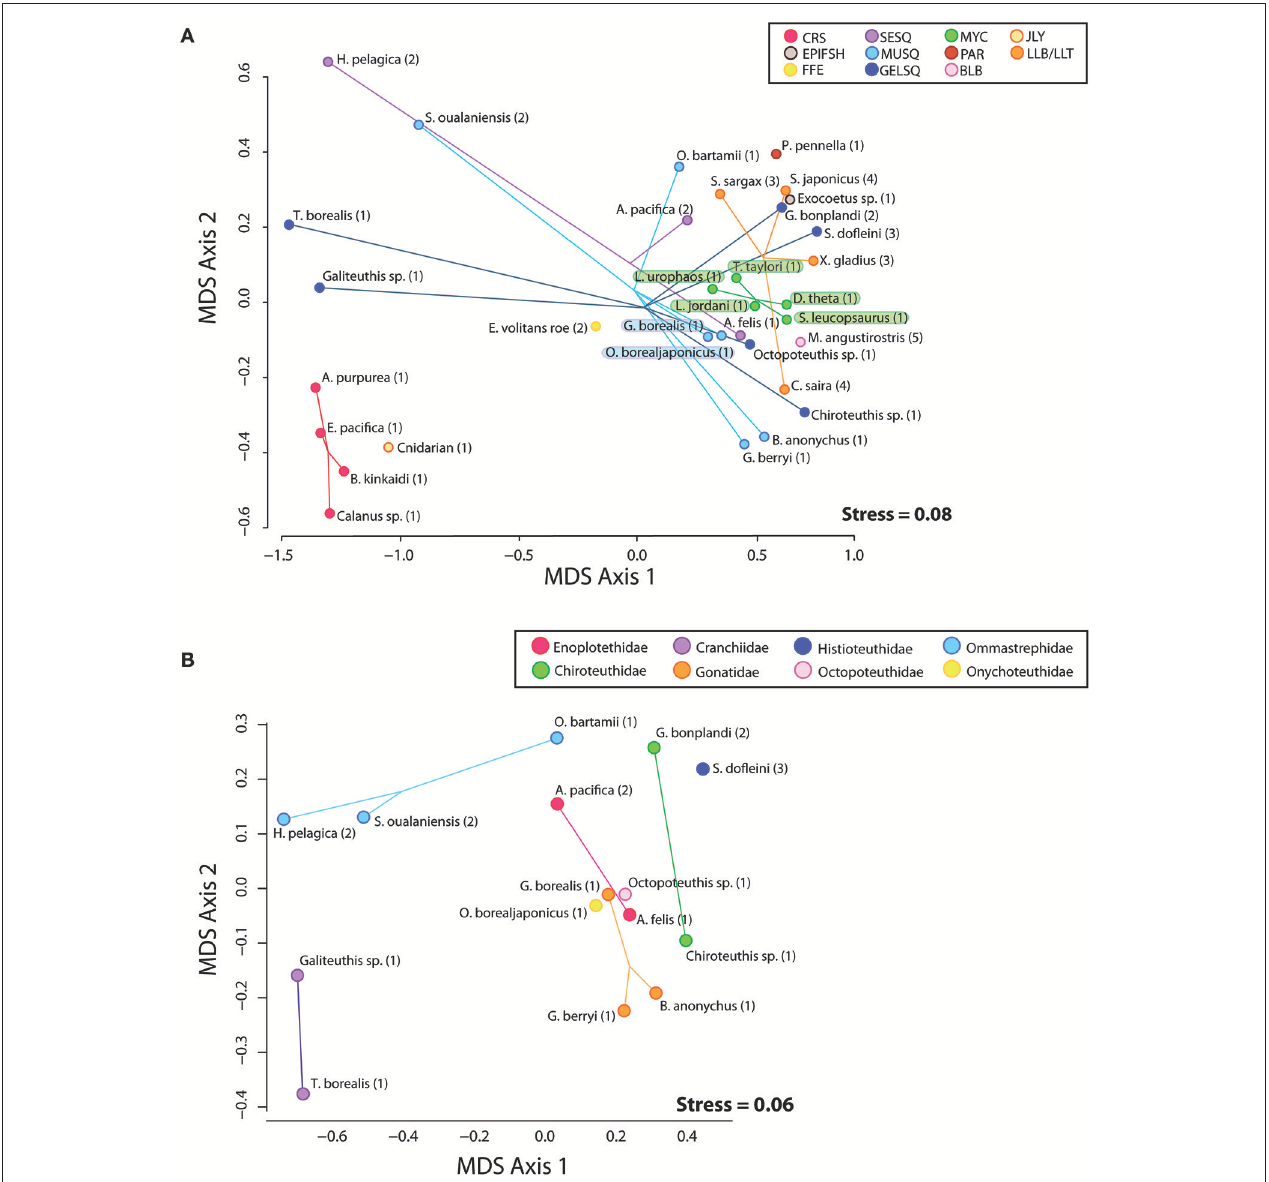
FIGURE 2 | (A) Plot of MDS1 and MDS2 scores derived from a non-metric multi-dimensional scaling analysis of raw FAME and FAlc values from all prey species. Species positions on the plot represent the mean FAME/FAlc composition of the subsamples from each species homogenate. Eleven functional groups are represented by colored spider plots and abbreviations: CRS, Crustacean; SESQ, Small Epipelagic Squid; MUSQ, Epi-Mesopelagic Muscular Squid; GELSQ, Bathy-Mesopelagic Squid; MYC, Mesopelagic Fish; LLA, Longline-Associated Prey; EPIFSH, Epipelagic Fish; FFE, Flying Fish Eggs; PAR, Ectoparasitic Copepod; BLB, Marine Mammal Blubber; JLY, Jellyfish. Collection regions coded by numbers: 1, NPTZ; 2, Hawaii; 3, California Current; 4, Asia; 5, Año. Nuevo breeding colony. (B) Plot of MDS1 and MDS2 scores derived from a non-metric multi-dimensional scaling analysis of raw FAME and FAlc values from squid species